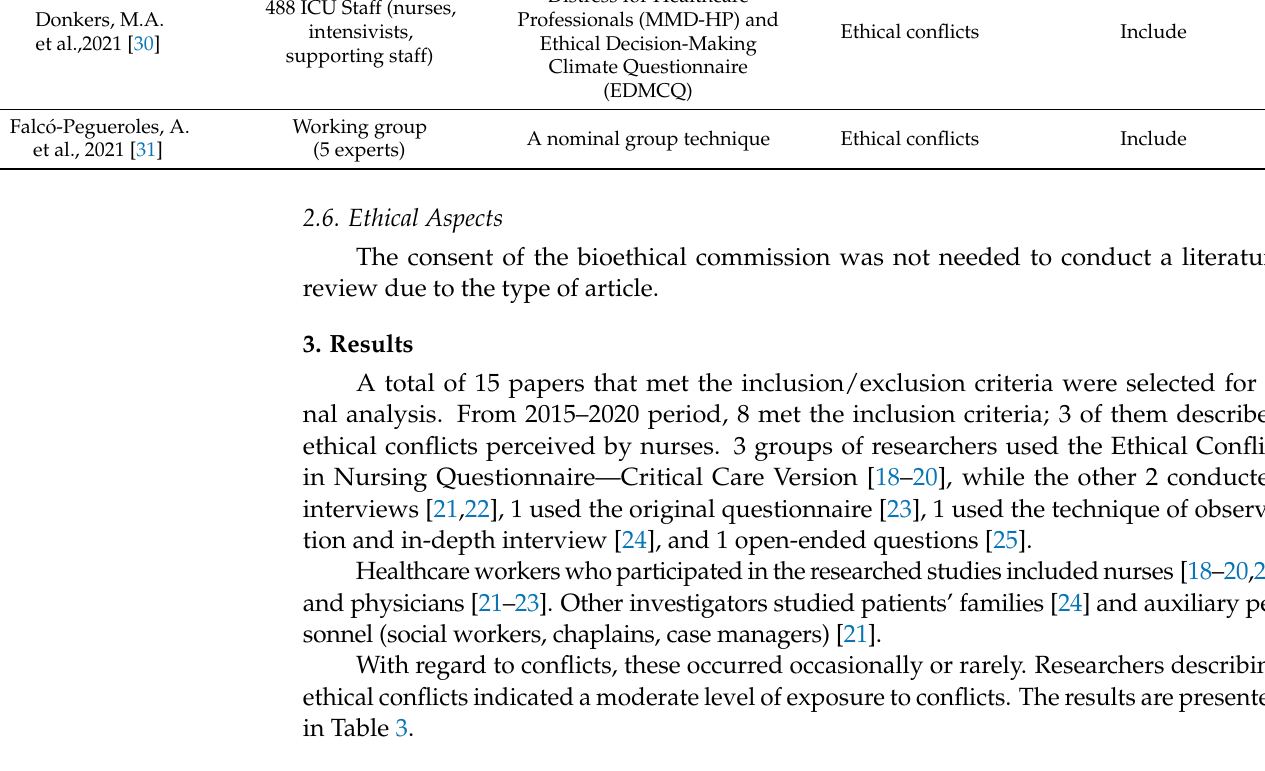
Table 3. Descriptive analysis of articles included in the systematic